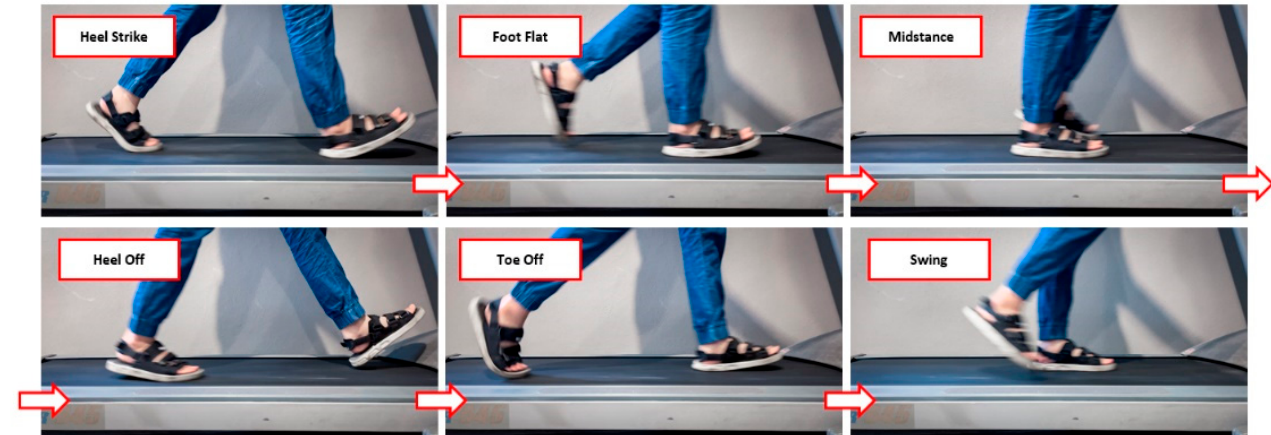
Figure 2. The phases of the gait cycle collected and analyzed in this